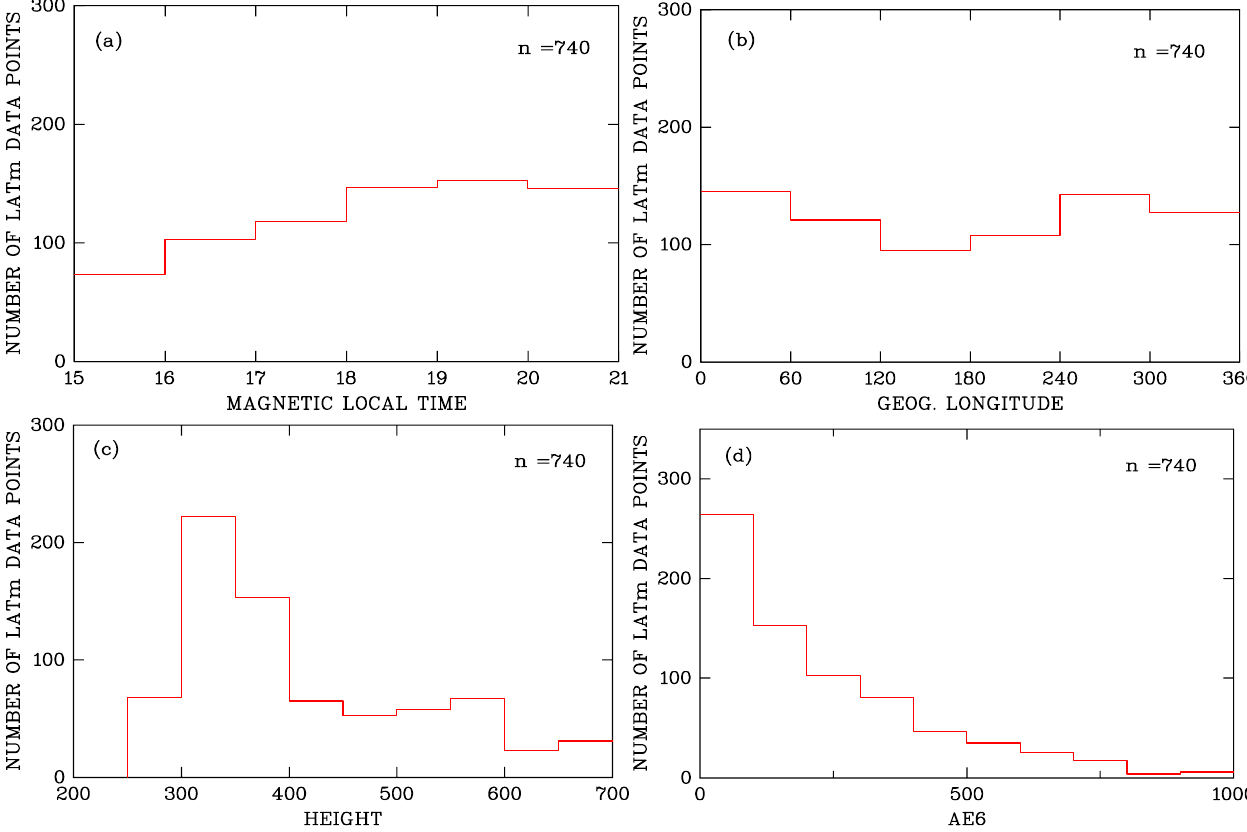
Fig. 2. Statistics of the data set analyzed in the present study. (a) Histogram indicating the magnetic local time distribution of the 740 electron density profiles parameterized. The time is given in hours. (b) Histogram indicating the geographic longitude distribution of the data set. The longitude is given in degrees east. (c) Histogram indicating the height distribution of the data set. The height is given in kilometers. (d) Histogram indicating the magnetic activity distribution of the data set. As a measure for this activity we use the AE 6 index defined in Eq. (1). The units of this index are